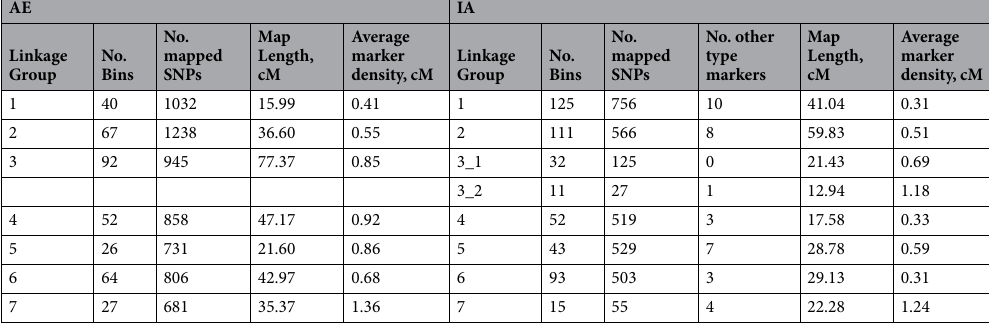
Synteny between the IA and AE populations. Extensive synteny was identified between the populations (Fig. 1, Supplementary Table S7). Synteny between LGs could be represented by a total of 260 SNPs at the same physical location in both populations (Supplementary Table S7). Some of the SNPs were located in sub-bins, yet the exact SNP within the sub-bin was unclear, which may cause the synteny between bins and sub-bins to be ambiguous, although the sub-bins tended to co-localize/cluster on the same LGs.